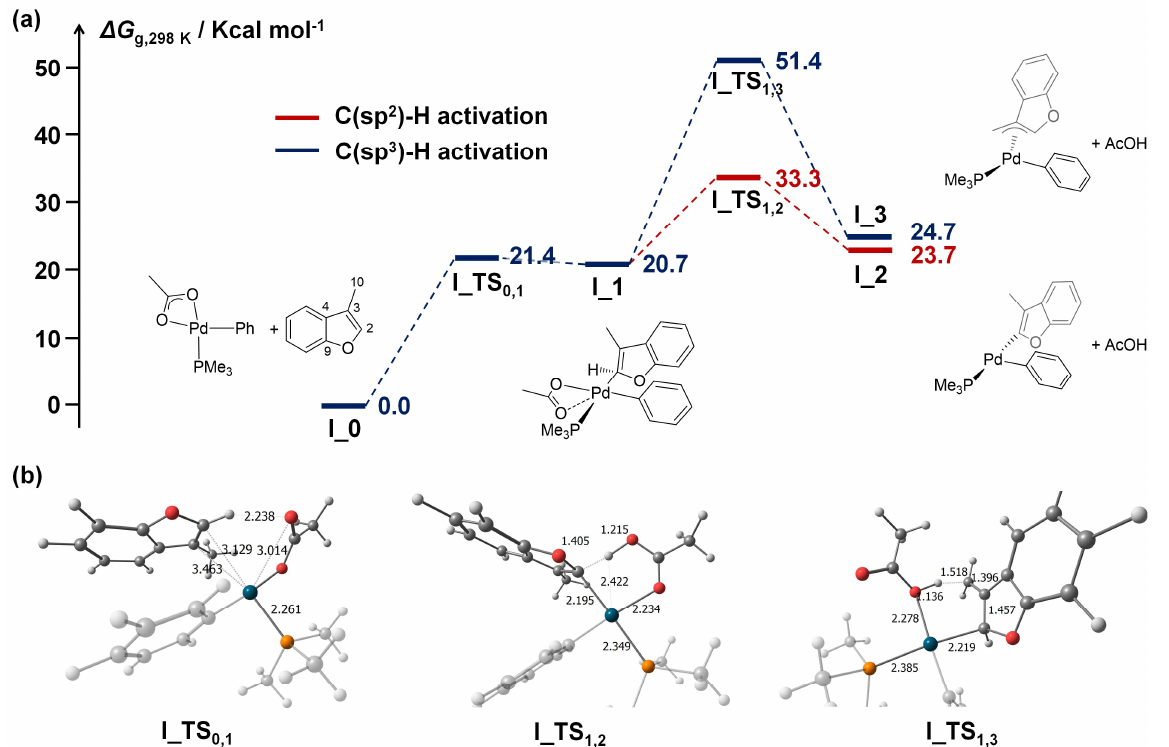
Figure 1. ( a ) Free energy reaction profile for C(sp 2 )−H (red) and C(sp 3 )−H (blue) activation by I . Numbers are Δ G in water at 298 °C (energies in kcal/mol). ( b ) Optimized geometries of transition states with selected bond lengths (Å). The phenyl and trimethylphosphine groups are drawn translucent for clarity.